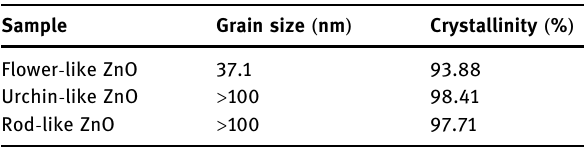
Table 1: The grain size and crystallinity of ZnO with di ff